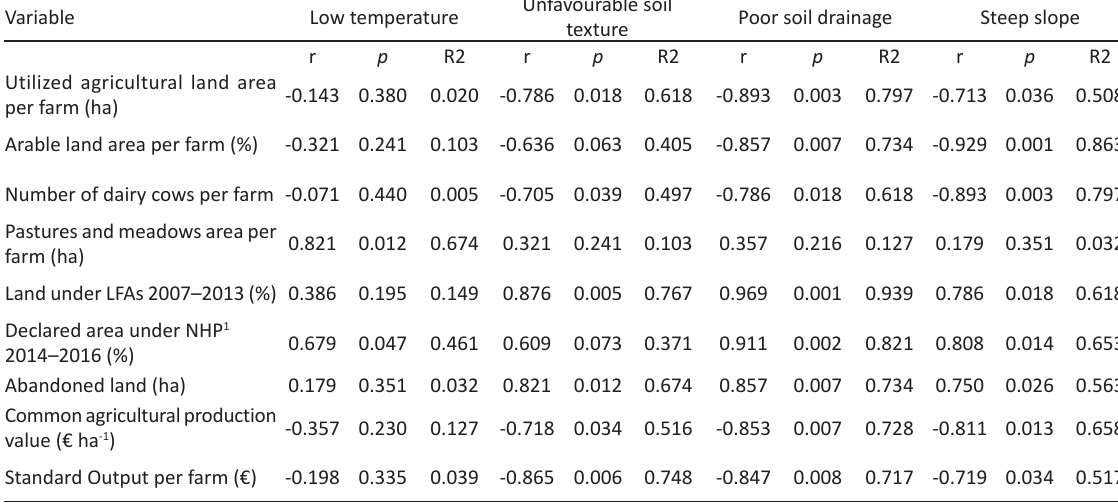
Table 6. Correlation (r) and determinant (R2) coefficients between the natural handicap criteria and basic land and farm characteristics Variable